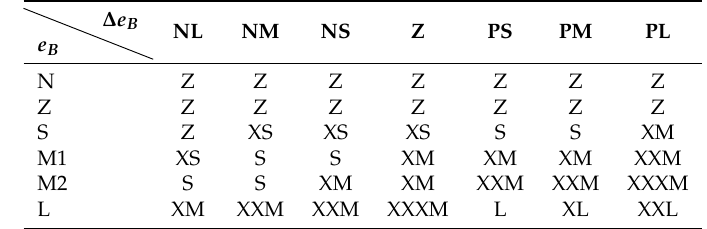
Table 3. Control rules of a pitch angle controller. N: Negative; Z: Zero; S: Small; M1: Medium1;